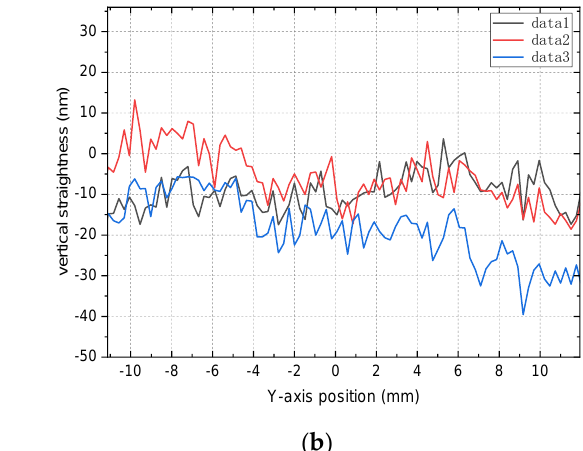
Figure 10. ( a ) Straightness error in the X -axis vertical direction. ( b ) Straightness error of machining position in X -axis vertical direction.